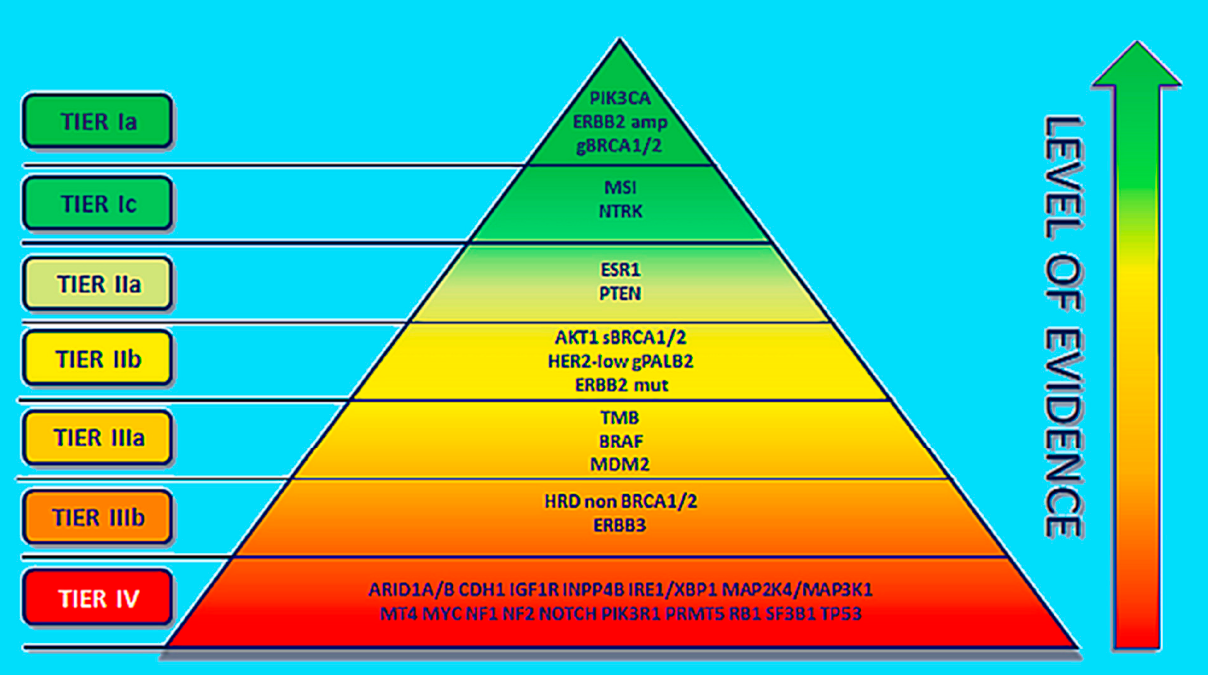
Figure 1. ESCAT ranking of molecular alterations in a speci fi c cancer type (adapted from ref. [3]).